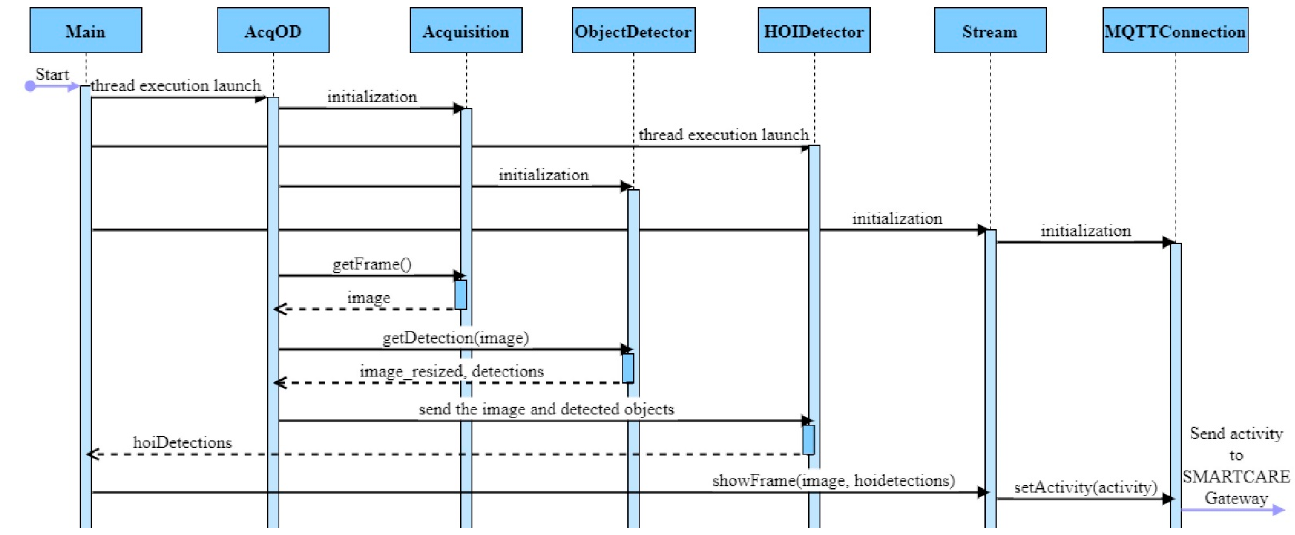
Figure 11. Communication diagram.